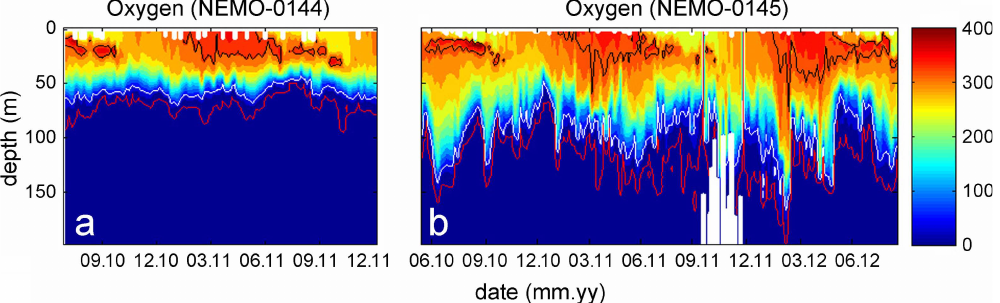
Fig. 8. Temporal evolution of oxygen (in µmolL − 1 ) as measured by NEMO-0144 ( a ) and NEMO-0145 ( b ). These plots illustrate the evolution of the subsurface oxygen maximum and the mesoscale variability of the interface between oxic and anoxic waters. The white and red isolines depict oxygen concentrations of 50 and 5µmolL − 1 , respectively. Note that in the basin interior (NEMO-0144) the temporal evolution of the depth of the isopycnals is very small. White vertical strips illustrate missing data resulting either from sensor malfunction or from the sensor reaching the